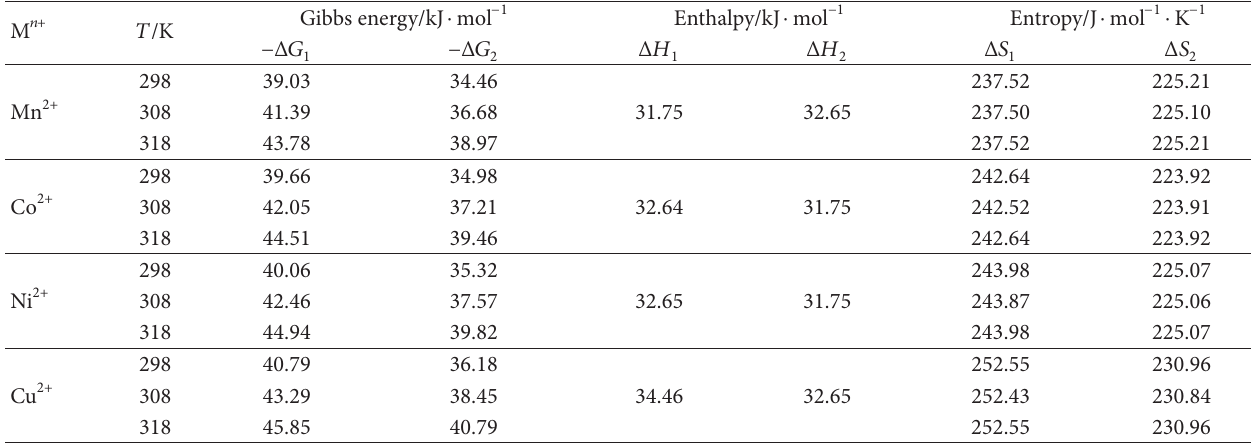
) in 10 (by volume) ethanol-water mixture and 0.1mol 1 %